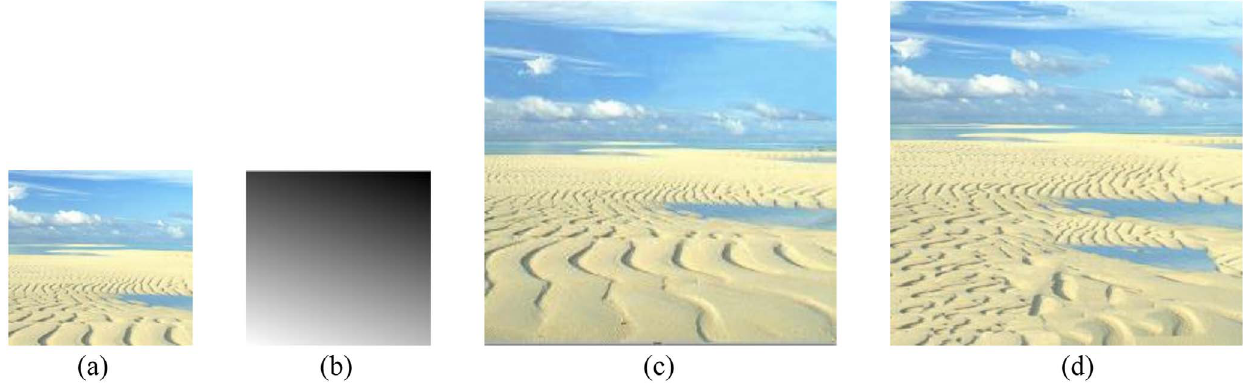
Figure 8. Perspective texture synthesis of a desert image. (a) the input example; (b) scale map with s =30 u , t =18 u ; (c) our result; (d) optimization [Kwatra et al. 2005] result.